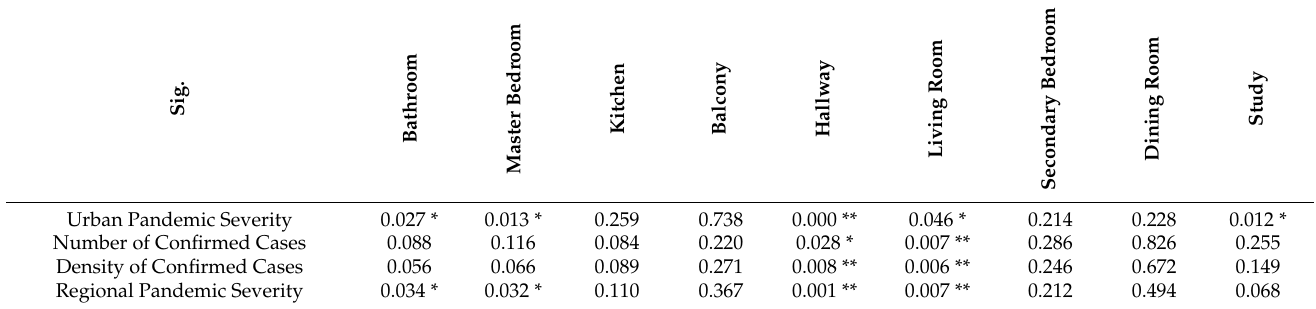
Table 2. The correlation results of indoor space